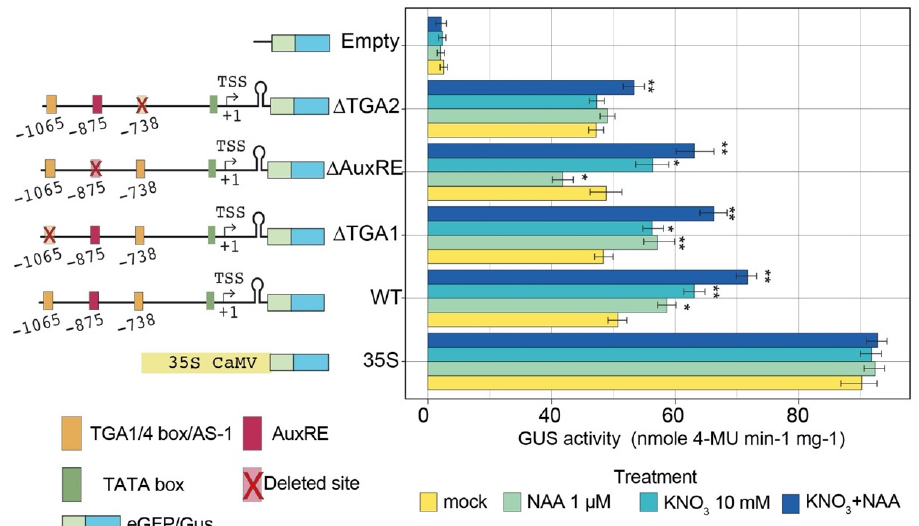
Figure 6. Differential contribution of TFBS within zma- MIR528a promoter to nitrate and auxin induction. eGFP-GUS reporter constructs under full-length zma- MIR528a promoter or promoters harboring deleterious mutations at either of two TGA1/4 (AS-1) or the AuxRE sites were transfected in maize protoplasts and assayed under control (mock), nitrate (10mM KNO 3 ), auxin (1 µ M 1-NAA), or combined treatment conditions. Deleted TFBS are shown as red-crossed boxes in each construct. Values represent GUS activity determined by fluorometry. 35S:GUS and vector lacking a promoter region (Empty) were used as positive and negative controls, respectively. Data represent mean ± S.E.M. of at least three independent experiments. One-way analysis of variance (ANOVA) and post hoc Tukey's test were used to determine the significant difference between treatments and mock for each construct. (* p < 0.05; ** p < 0.01).